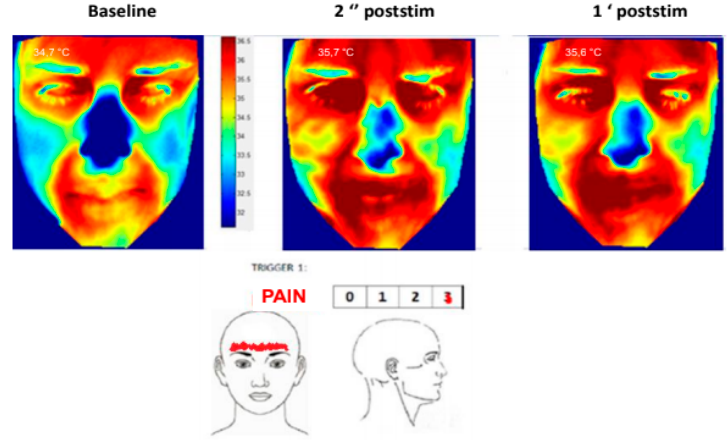
Figure 3. Example of the IR imaging and the corresponding VAS template.